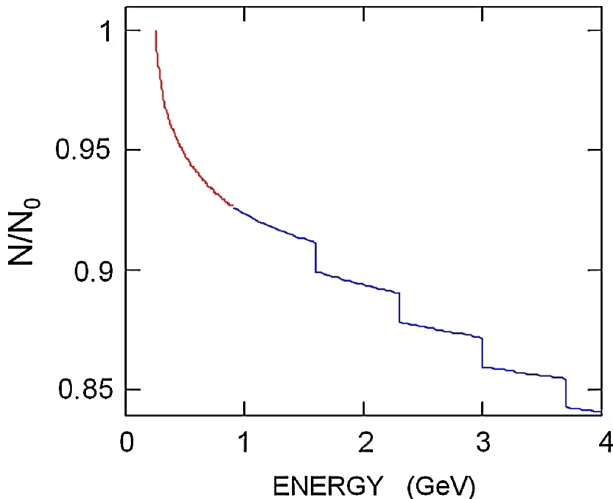
FIG. 14. (Color) Survival rate as a function of energy; the red and blue lines show, respectively, the fraction decaying in the preaccelerator and RLA. Vertical drops correspond to the beam transport in